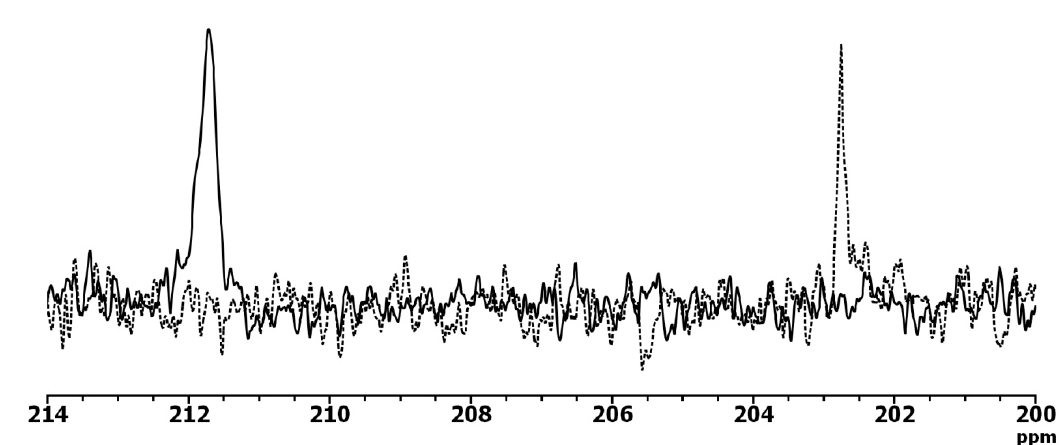
Figure 4. Representative fragment of 13 C NMR spectra (D 2 O) of IDADTC (solid line) and complex with indiumin 1:3 ratio (dotted line) (characteristic shift of CSS resonance).